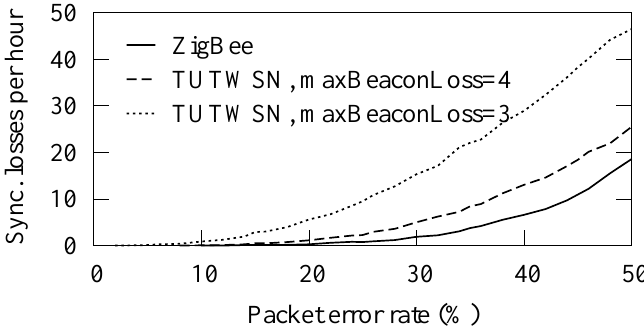
Figure 9. Synchronization losses due to several consecutive beacon